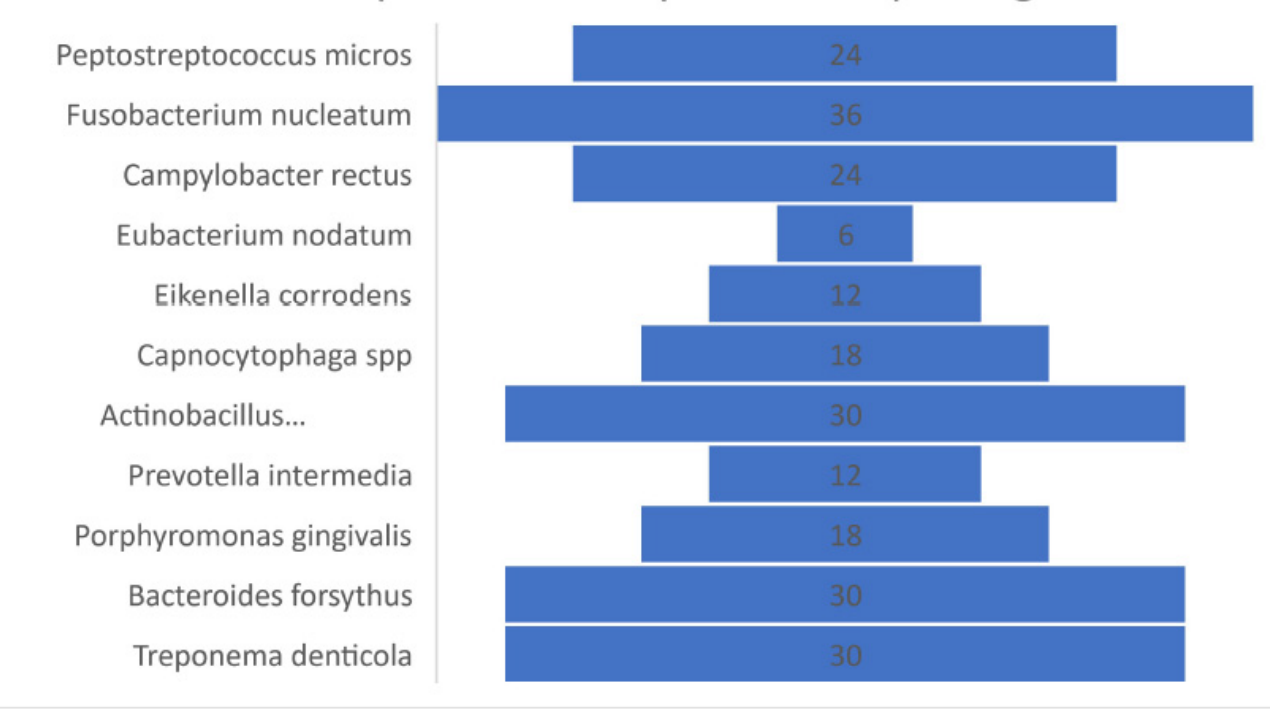
Figure 5. Graphic description of the number of patients in the study with the presence of pathogens. Table 4. The final results of periodontal diseases in the three groups at the end of the research pe- riod.